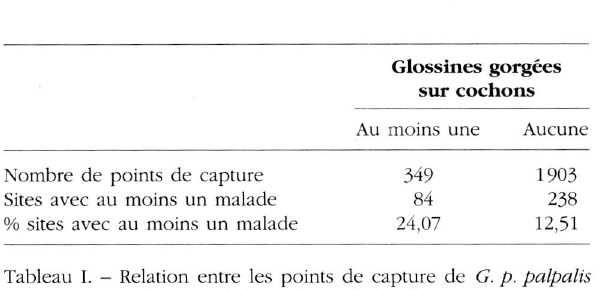
Tableau I. - Relation entre les points de capture de G. p. palpalis gorgées sur cochons et l'habitat des malades de THA.